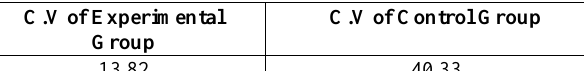
activities in the Post-test